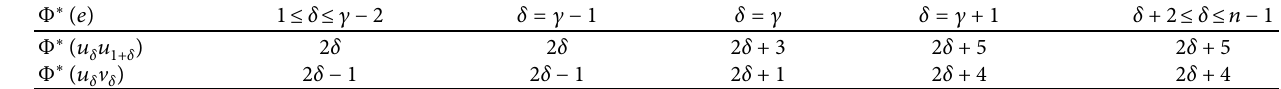
Table 18: Edge labeling of Φ ∗ ( e ) .